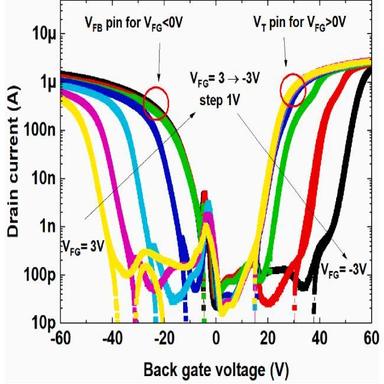
Drain current versus back-gate voltage for various front-gate voltages of the devices with the undoped source/drain contacts and N + poly-Si gate.